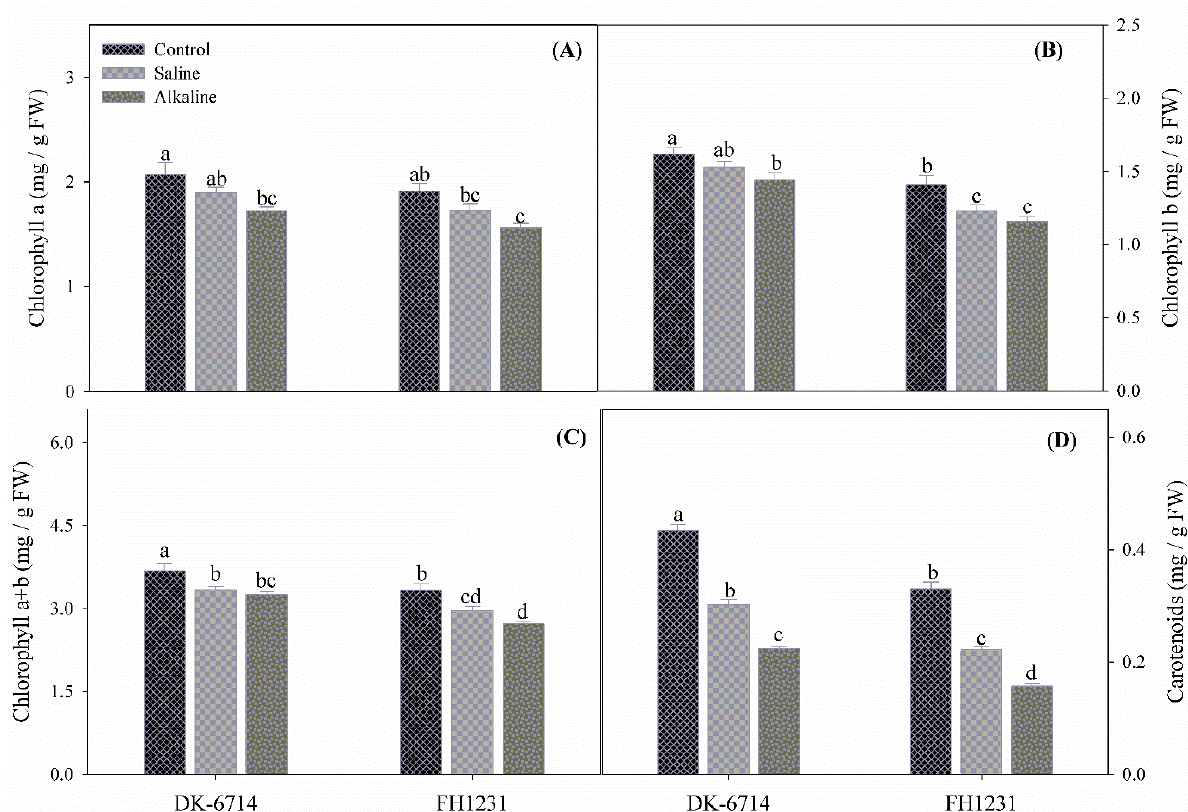
Figure 3. Effect of salinity and alkalinity stress on ( A ) chlorophyll a, ( B ) chlorophyll b, ( C ) chlorophyll a + b, and ( D ) carotenoid content of 20-day-old maize seedlings of two hybrids (DK-6714 and FH-1231). The bars represent the standard error (SE) of the four replicates. Similar small letters above bars represent nonsignificant (ns) differences among treatments ( p ≤ 0.05).